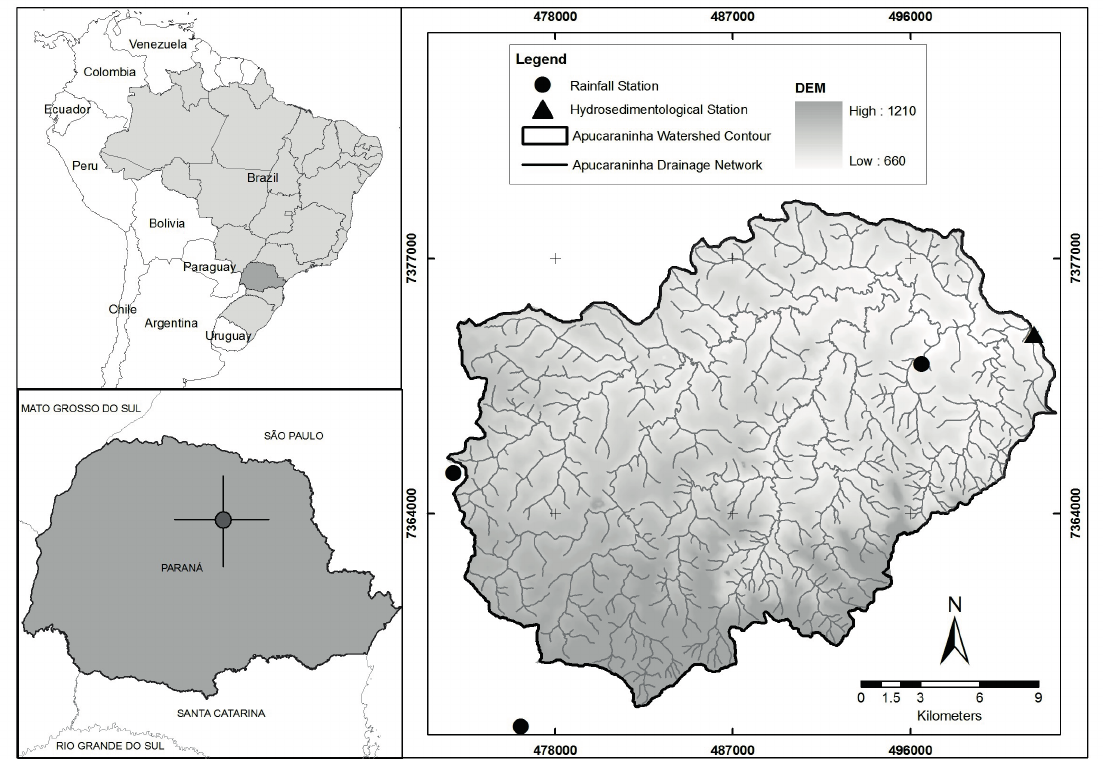
Fig. 1 Geographical location of the Apucaraninha River watershed in Southern